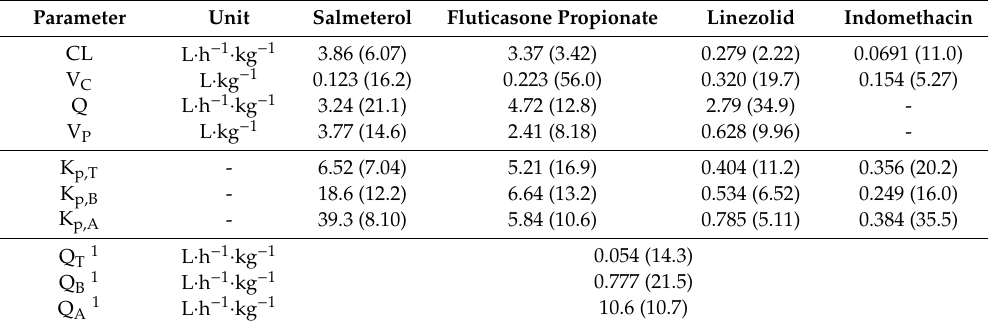
Table 1. Model parameters (% CV).